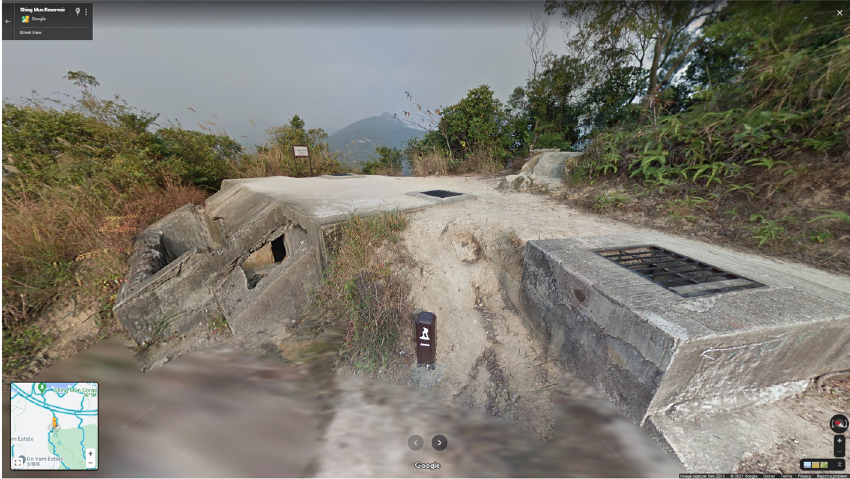
Fig. 6 One of the better-preserved pillboxes along the Gin Drinkers ’ Line (Source: Google Street